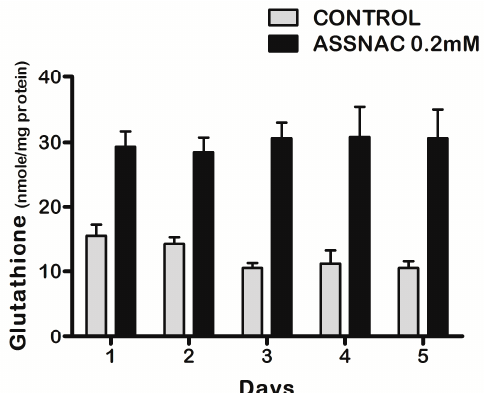
Figure 2. Effect of consecutive daily treatments of ASSNAC on glutathione level in ARPE-19 cells. Confluent ARPE-19 cells were incubated without (control) or with ASSNAC (0.2 mM) consecutively added for 5 days. Cultures were harvested every day and glutathione was extracted and determined. Significant differences between the treated and control groups were found ( p ≤ 0.01).